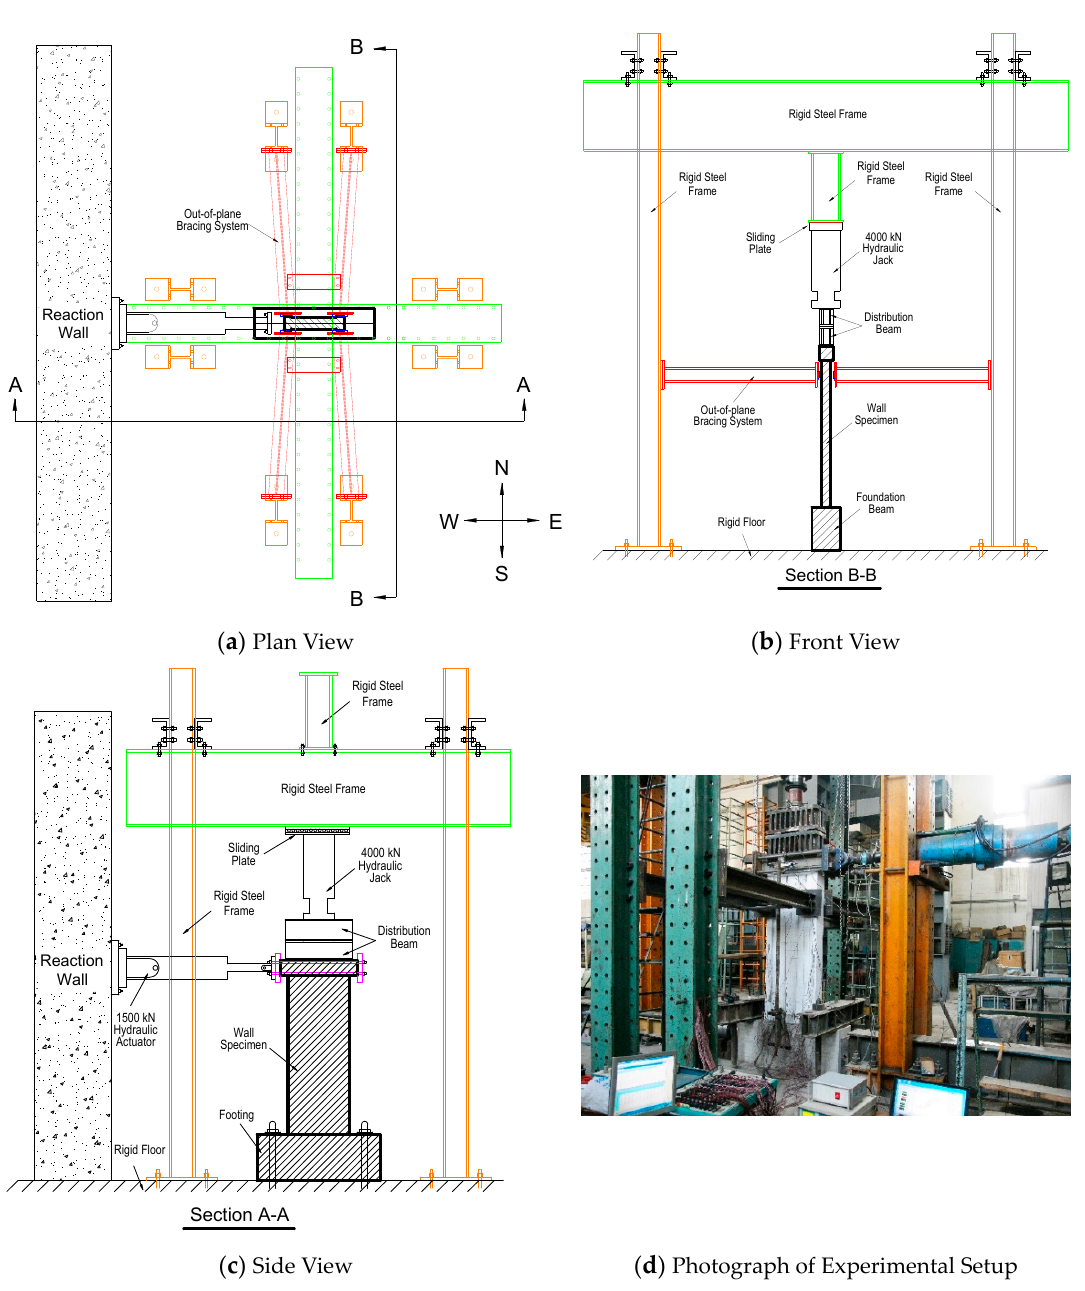
Figure 3. Details of Experimental Setup ( a ) Plan View; ( b ) Front View (Section B-B); ( c ) Side View (Section A-A); and, ( d ) Photograph of Experimental Setup.